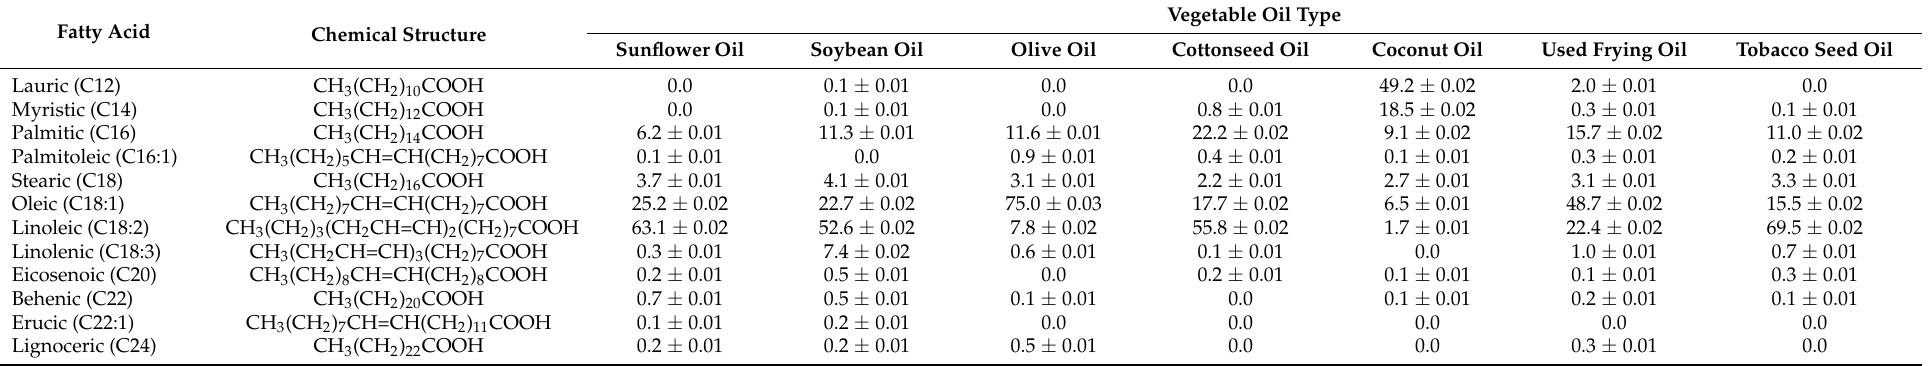
Table 2. Fatty acid composition of vegetable oils, % m/m with measurements